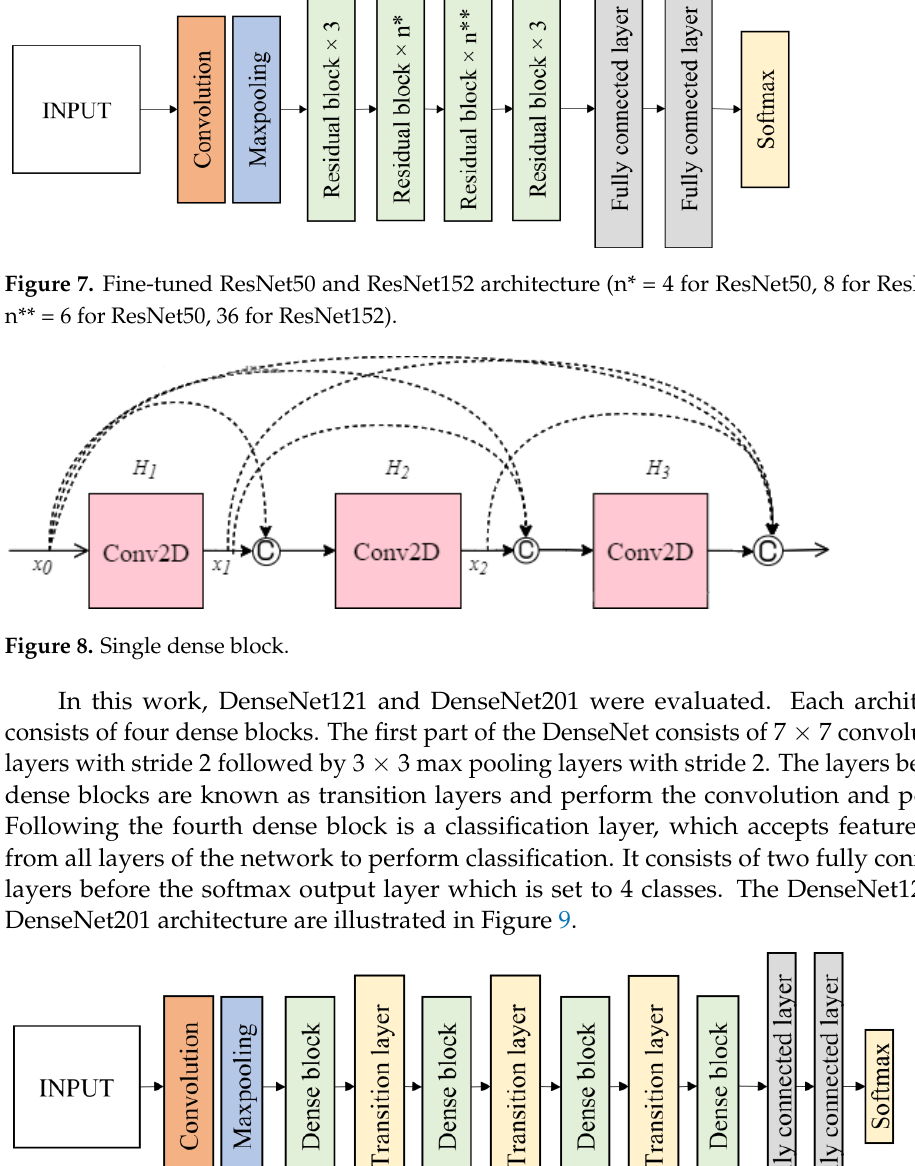
Figure 6. Single residual block.